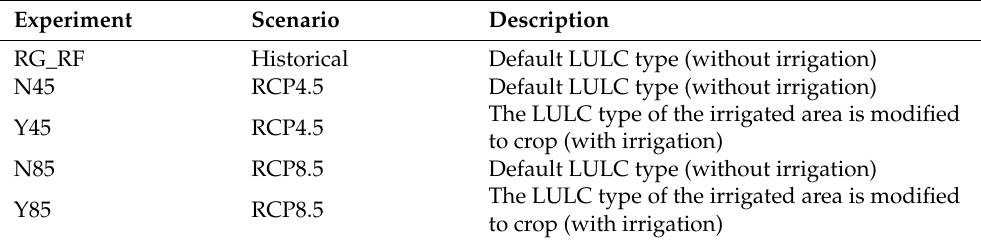
Table 1. Description of the irrigation experiment in this study. Experiment Scenario Description RG_RF Historical Default LULC type (without irrigation) N45 RCP4.5 Default LULC type (without irrigation) The LULC type of the irrigated area is modified RCP4.5 to crop (with irrigation) N85 RCP8.5 Default LULC type (without irrigation) Y85 RCP8.5 to crop (with